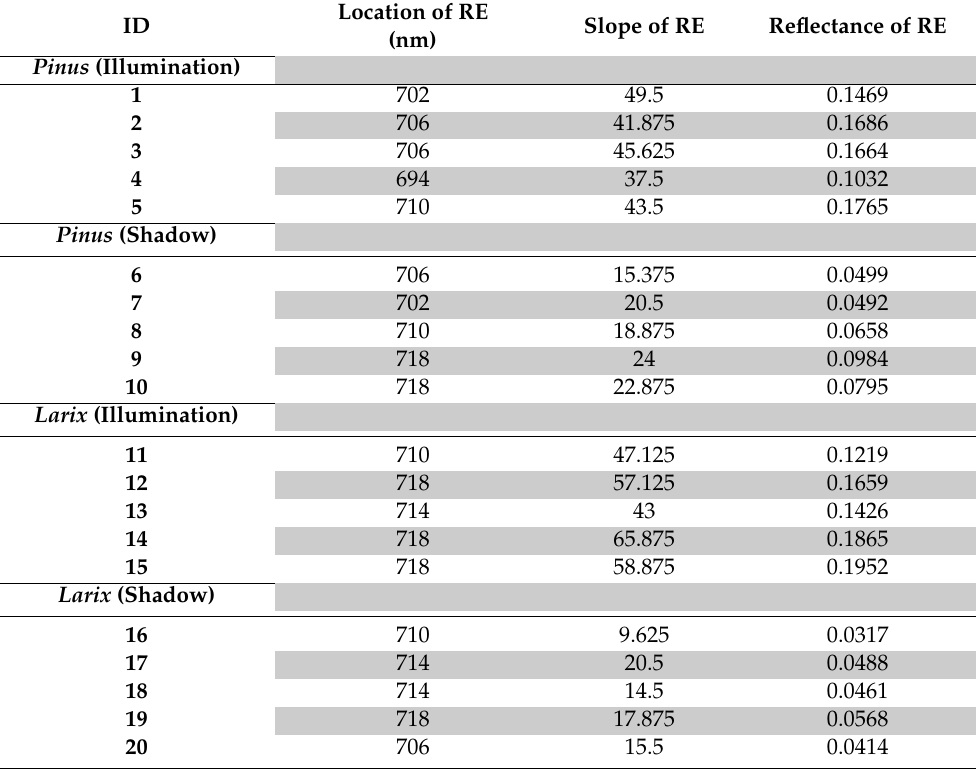
Table 2. Red Edge Parameters of Pinus and Larix with Di ff erent Illumination / Shadow Proportions. Twenty of the 80 pixels’ parameters are